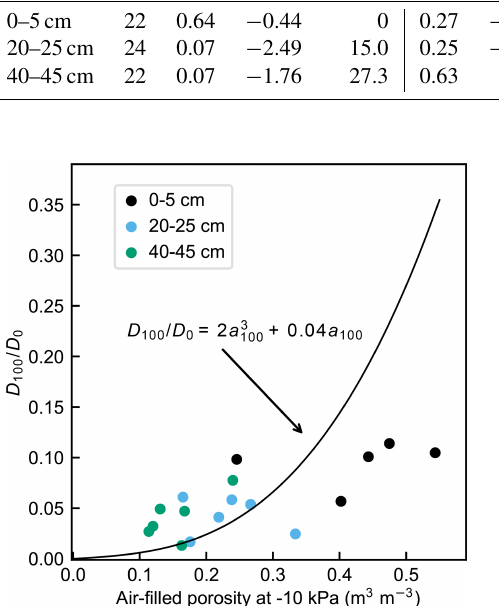
Figure 4. Measured relative diffusivity at − 100cmH 2 O ( − 10kPa) matric potential as a function of air-filled porosity and the empirical equation by Moldrup et al.